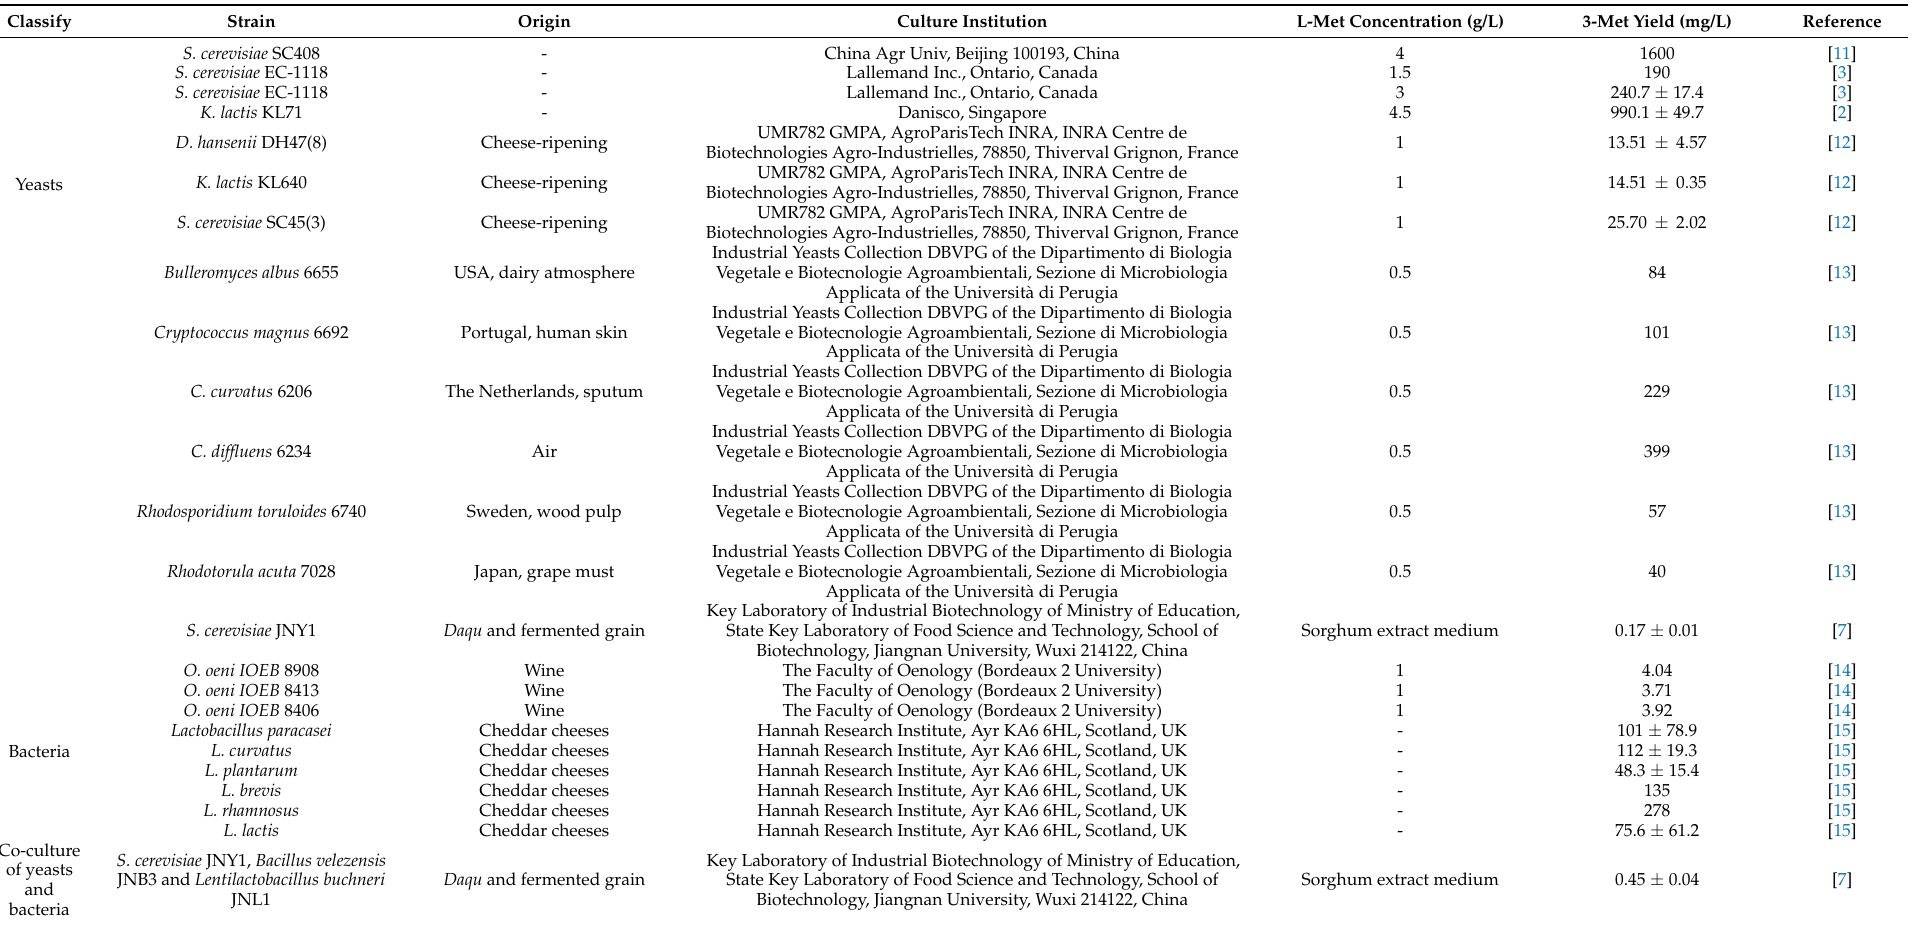
Table 1. Summary of 3-Met yield in natural